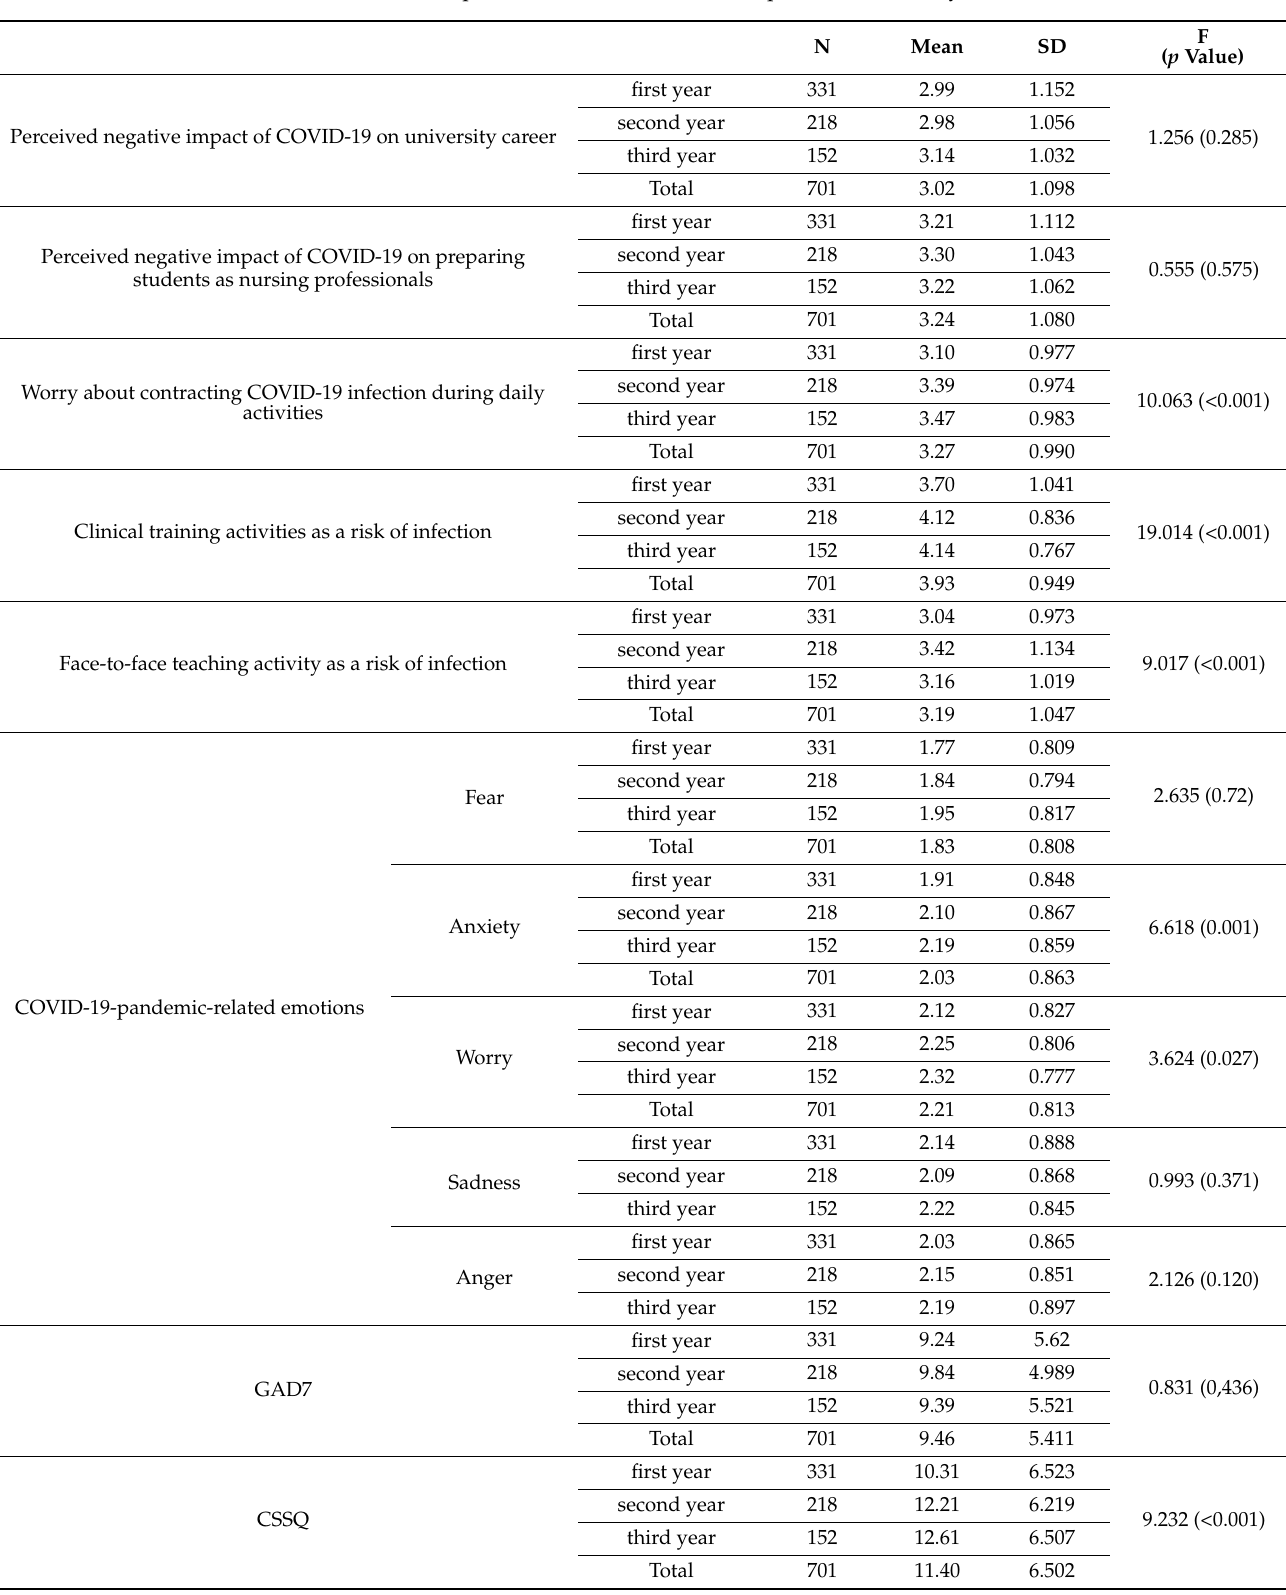
Table 1. Descriptive characteristics of the sample for all the study